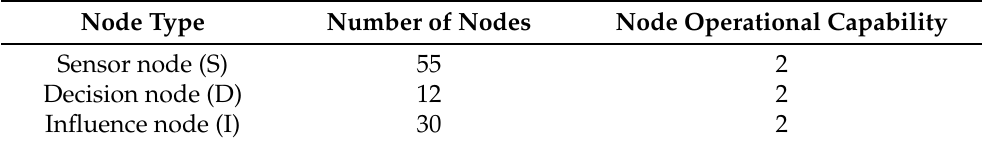
Table 1. Heterogeneous combat network